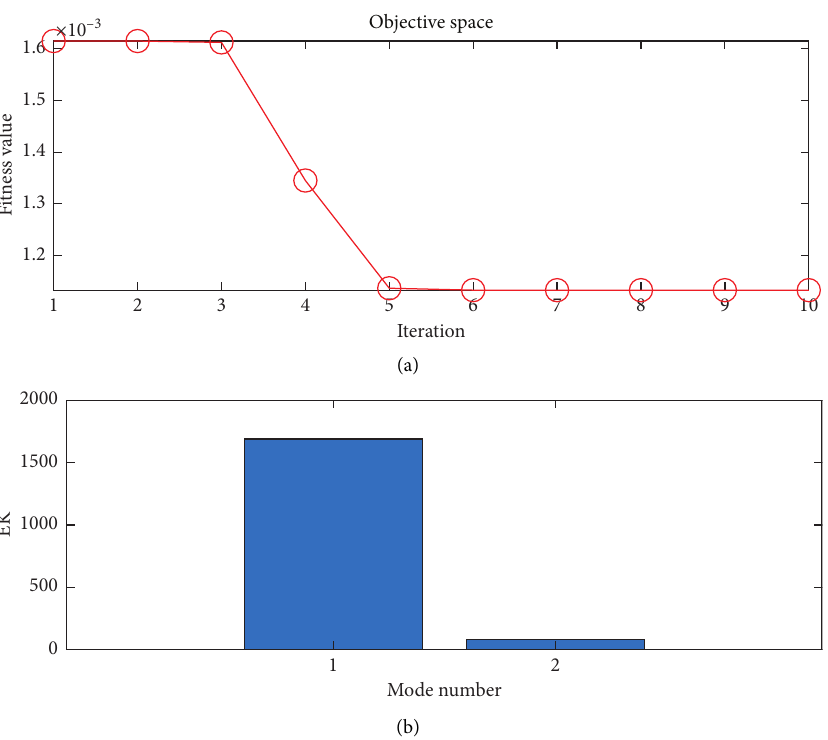
Figure 8: Simulated signals of case 1: the optimization process based on PAVMD: (a) PSO convergence curve and (b) the EK value of each